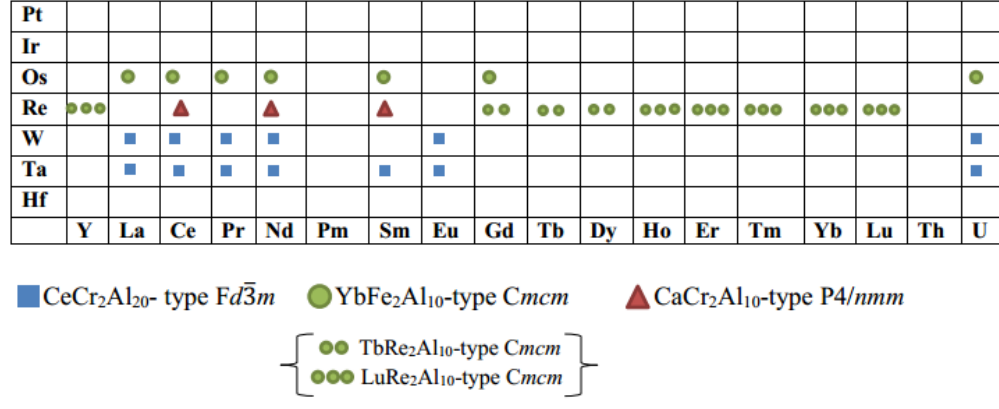
Figure 2. Summary of the reported A-T-Al phases with AT 2 Al 20 and AT 2 Al 10 compositions containing 5 d T metal. Di ff erent symbols present various symmetries according to the legend presented below the table. The symbols demonstrate the crystal structure of the phase in a specific system. The data are from [34].